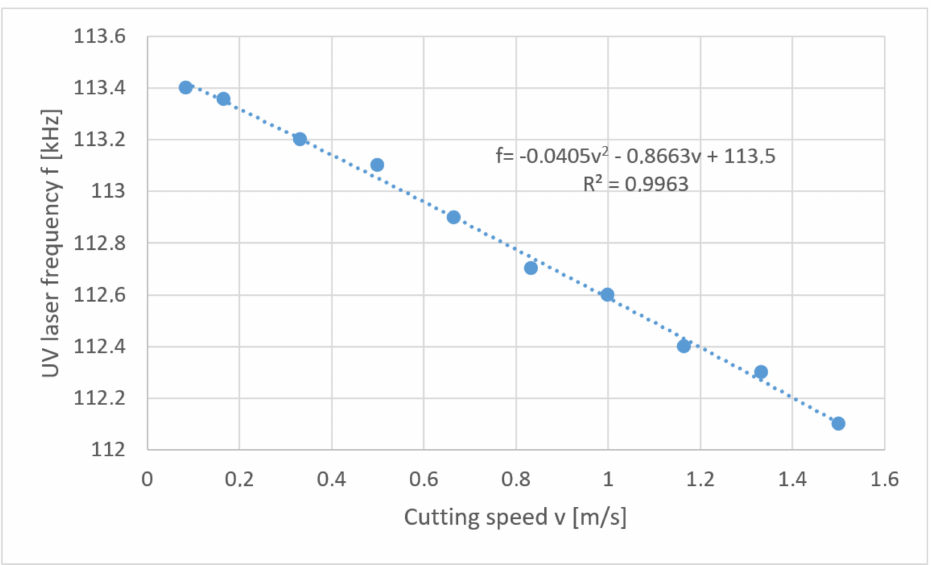
Figure 14. Reverse task solution for cutting foil with thickness t = 70 µ m.